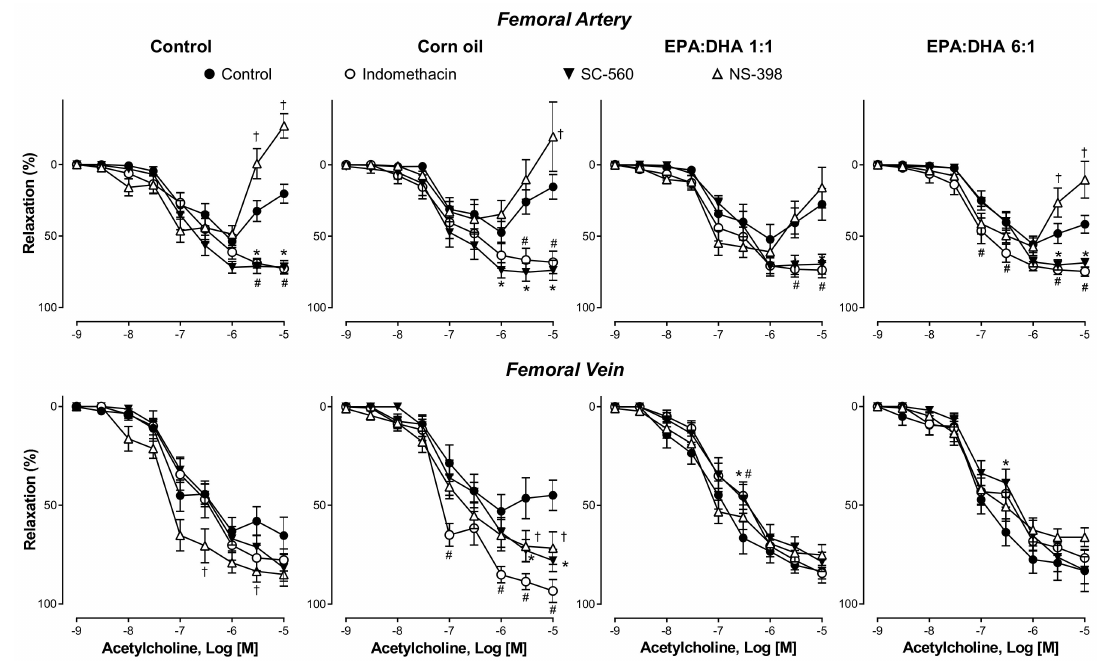
Figure 3. The role of cyclooxygenase (COX)-1 and COX-2 in the ACh-induced endothelium-dependent relaxation of the femoral artery and vein of the control group, the corn oil group, and the EPA:DHA 1:1 and 6:1 groups. Rings were precontracted with 5-HT (1 µ M) before the construction of a concentration–relaxation curve to ACh. Some rings were incubated for 20 min with either indomethacin (10 µ M, a non-selective inhibitor of cyclooxygenases), SC-560 (0.3 µ M, a selective inhibitor of COX-1), or NS-398 (3 µ M, a selective inhibitor of COX-2). Results are expressed as percentage of relaxation and given as means ± S.E.M. of ten rats per group. # p < 0.05 for indomethacin vs. control, † p < 0.05 for NS-398 vs. control, and * p < 0.05 for SC-560 vs. control.